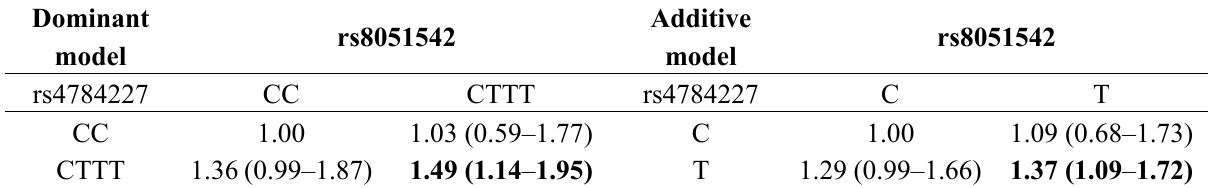
Table 4. Combined odds ratios for the two significant SNPs in TOX3/LOC643714 in Chinese